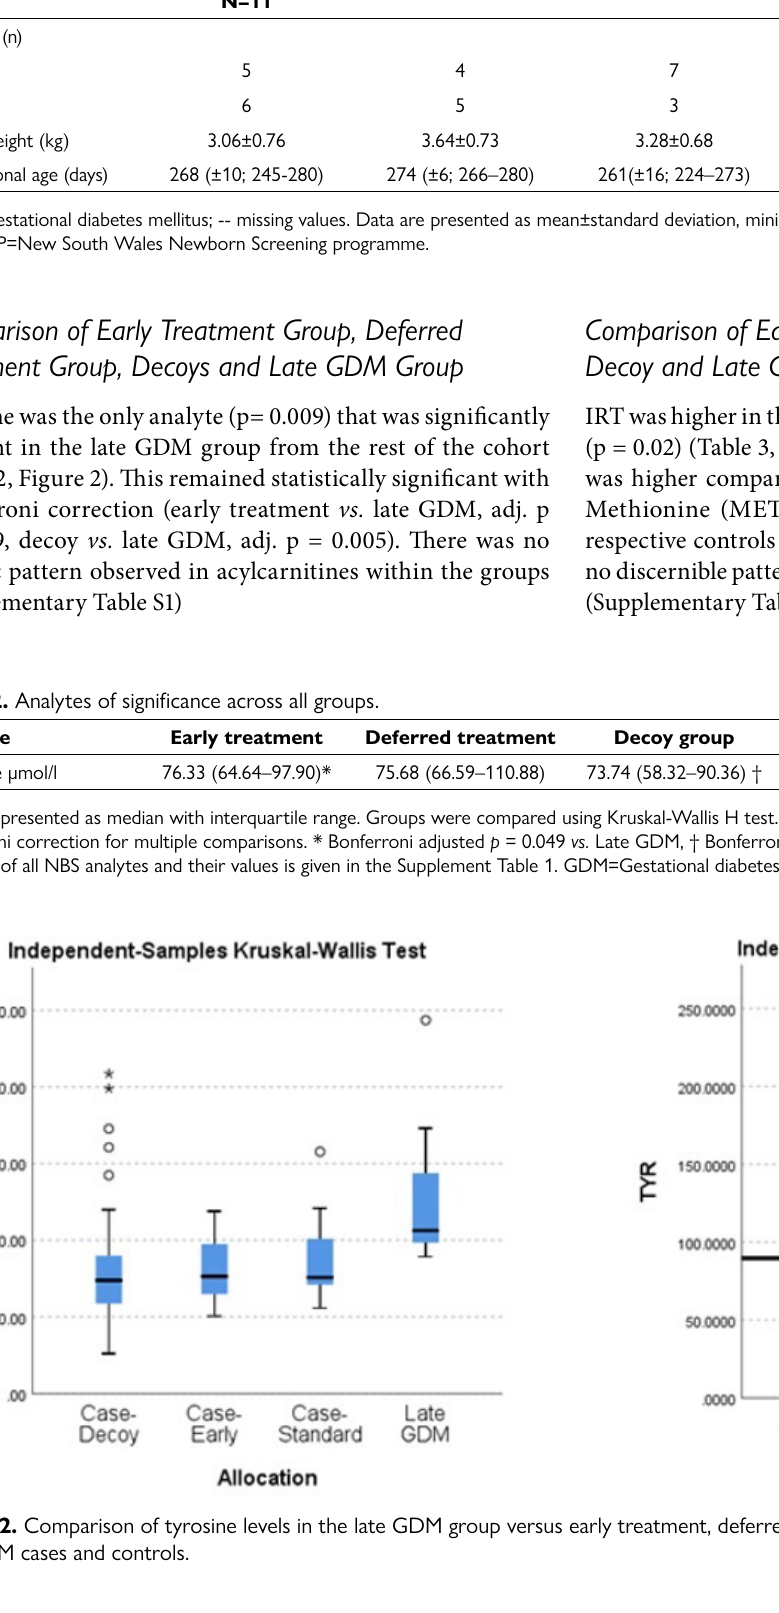
Table 1. Comparison of neonatal characteristics. Characteristics